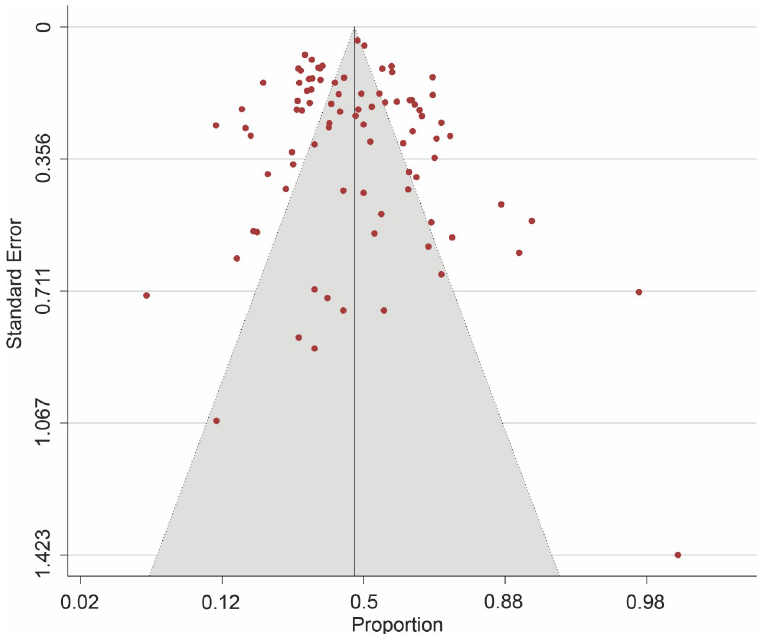
Fig 3. Funnel plot showing no publication bias for the studies reporting HCV genotype 1 in Southeast Asia.